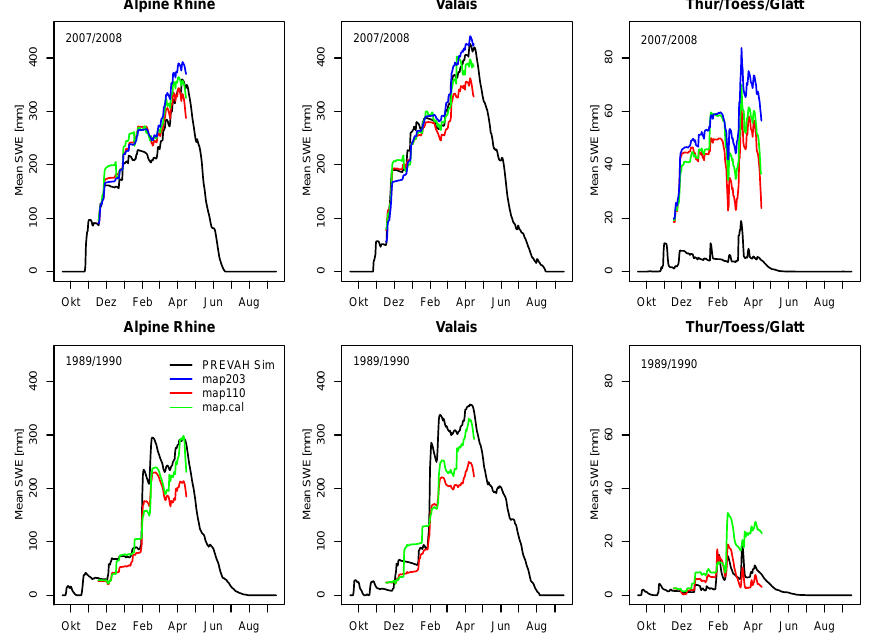
Fig. 12. Daily mean SWE in the Alpine Rhine catchment (left) and the Valais (right) for the hydrological years 2008 (top) and 1991 (bottom). SWE is illustrated as PREVAH simulations (black), map203 (blue), map110 (red) and map110 cal (green).